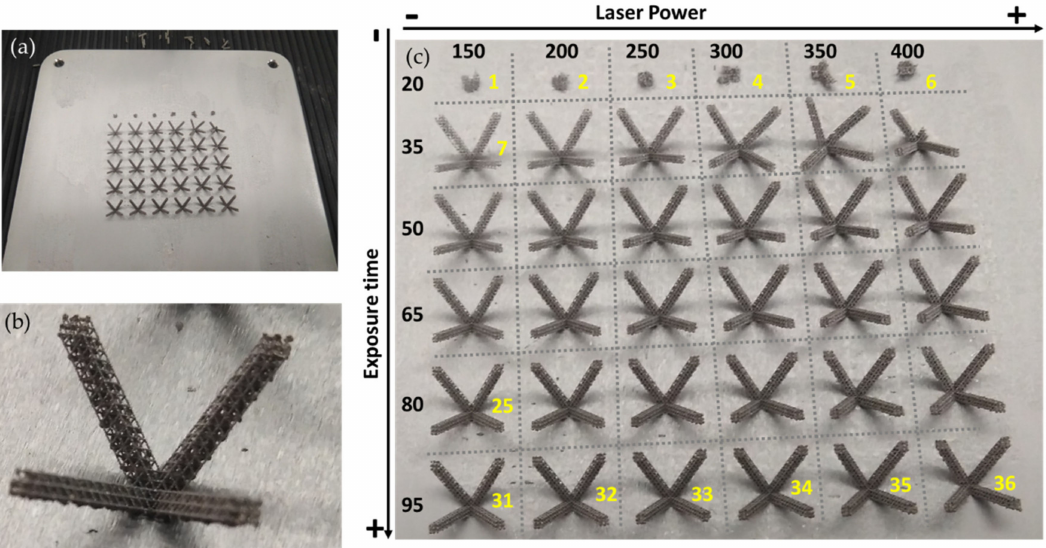
Figure 3. ( a ) Printed geometries for parameter tests. ( b ) Zoom on printed geometry for parameter tests. ( c ) Printed geometries organized according to tested